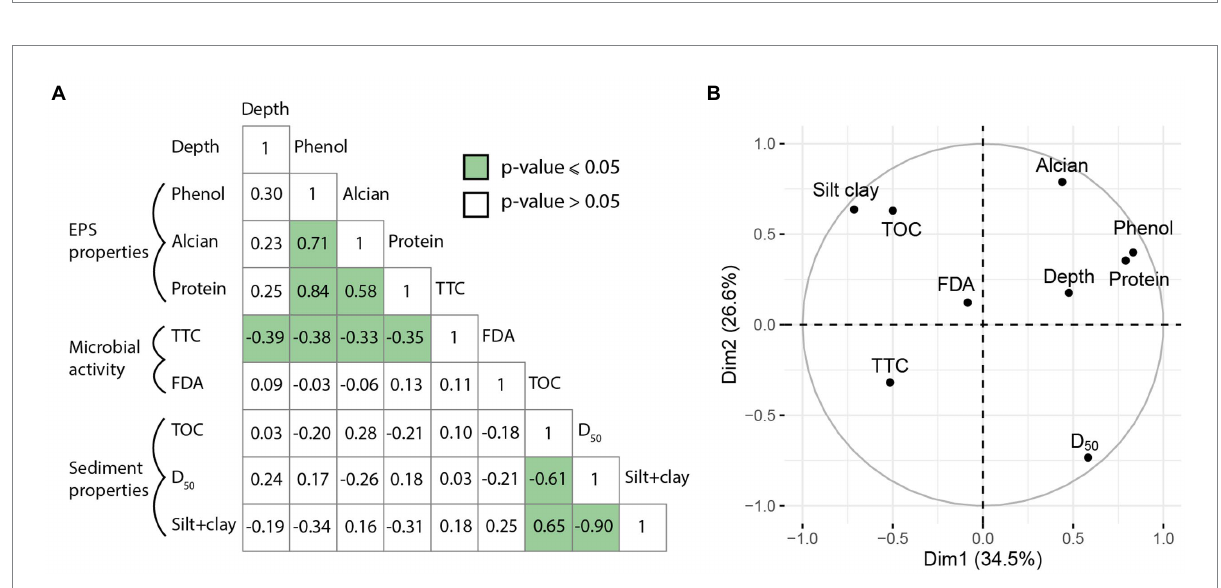
FIGURE 7 Middle, Principal Components Analysis circle plot of correlation between the samples from the BXN Long Core. (A) Correlation matrix of Pearson’s r coefficients between EPS properties, sedimentological factors and depth for the 16 samples. Green boxes indicate value of p ≤ 0.05. (B) Principal Components Analysis circle plot of variables for BXN-Long Core.